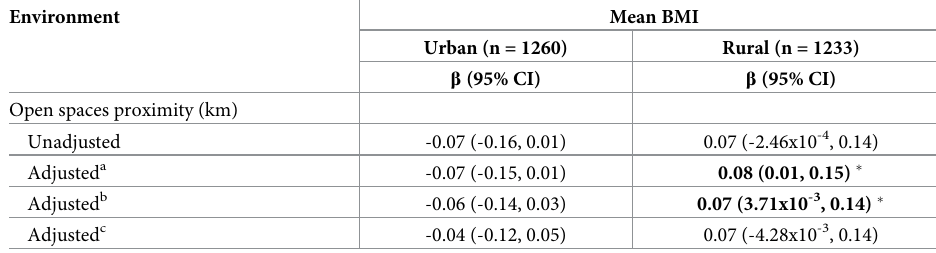
Table 2. Urban-rural-specific unadjusted and adjusted β coefficients (Confidence Intervals in brackets) for the association of open spaces proximity with mean Body Mass Index.